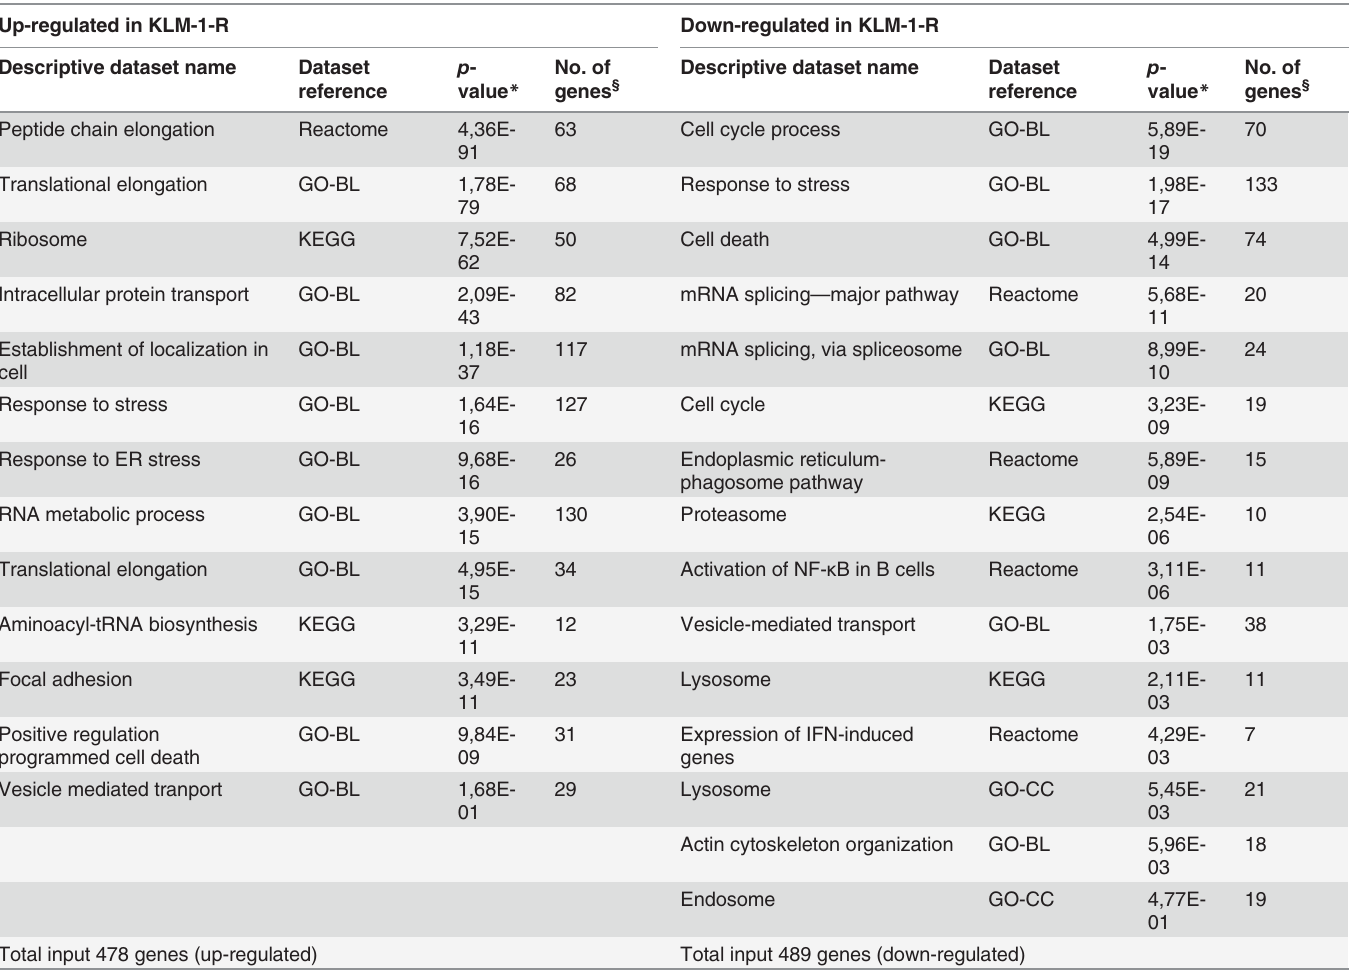
Table was generated by STRING using GO, KEGG, and Reactome databases, as indicated under dataset reference. §Number of genes in our data set that are also present in the respective data-set list or pathway list. * p-value represents the probability that 478 genes would show the distribution to match the same number of gene hits in the respective list. Datasets are ranked according to p-value. P < 0.001 is considered statistically signi fi